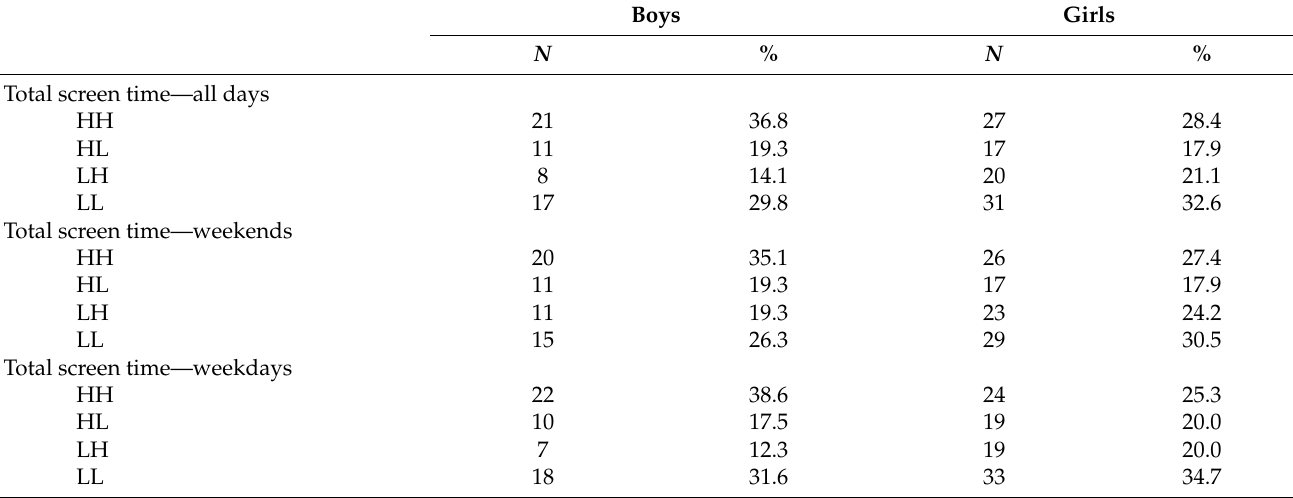
Table 2. Participants’ distribution in categories of daily screen time at 15 y to 17 y. Boys